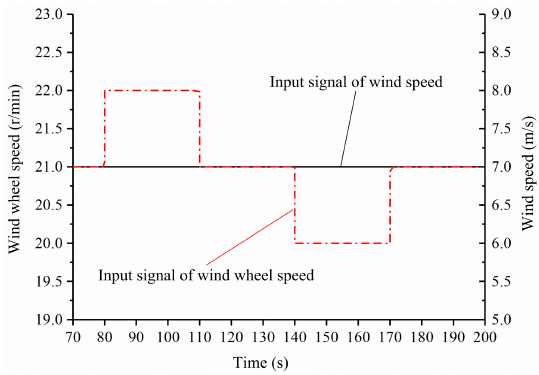
Figure 11. The second input step signal.